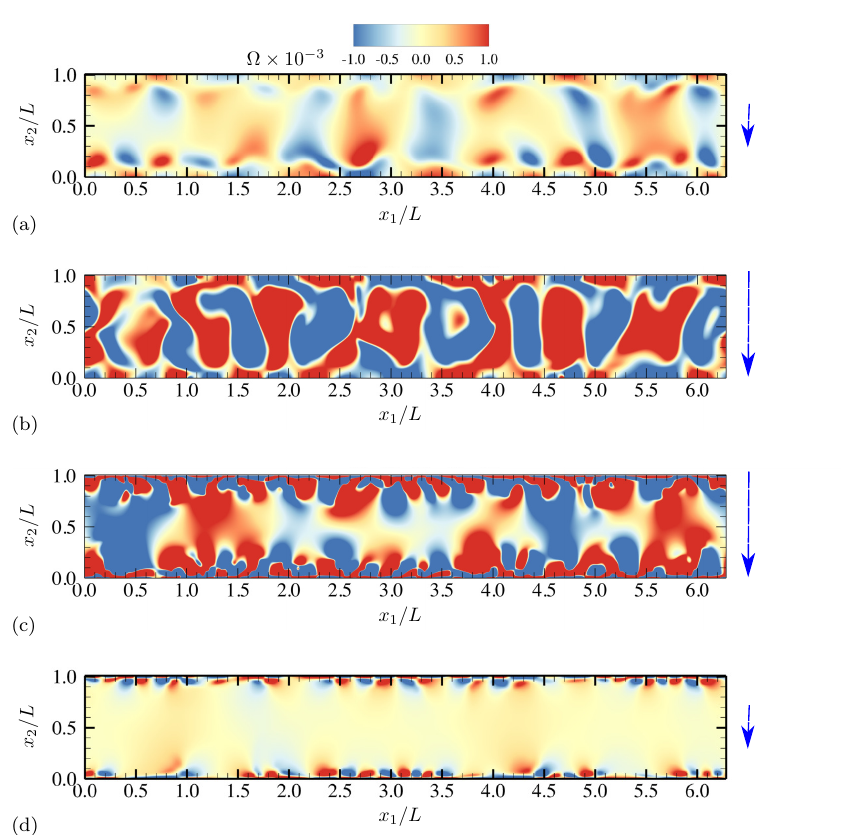
Figure 5. Time series of vorticity Ω for half an oscillation period at ( a ) θ = 0.64 π , ( b ) 0.88 π , ( c ) 1.12 π and ( d ) 1.4 π . The vertical arrows denote the direction and relative magnitude (not to scale) of the applied electric field. The diffusivity ratio is D − / D + =